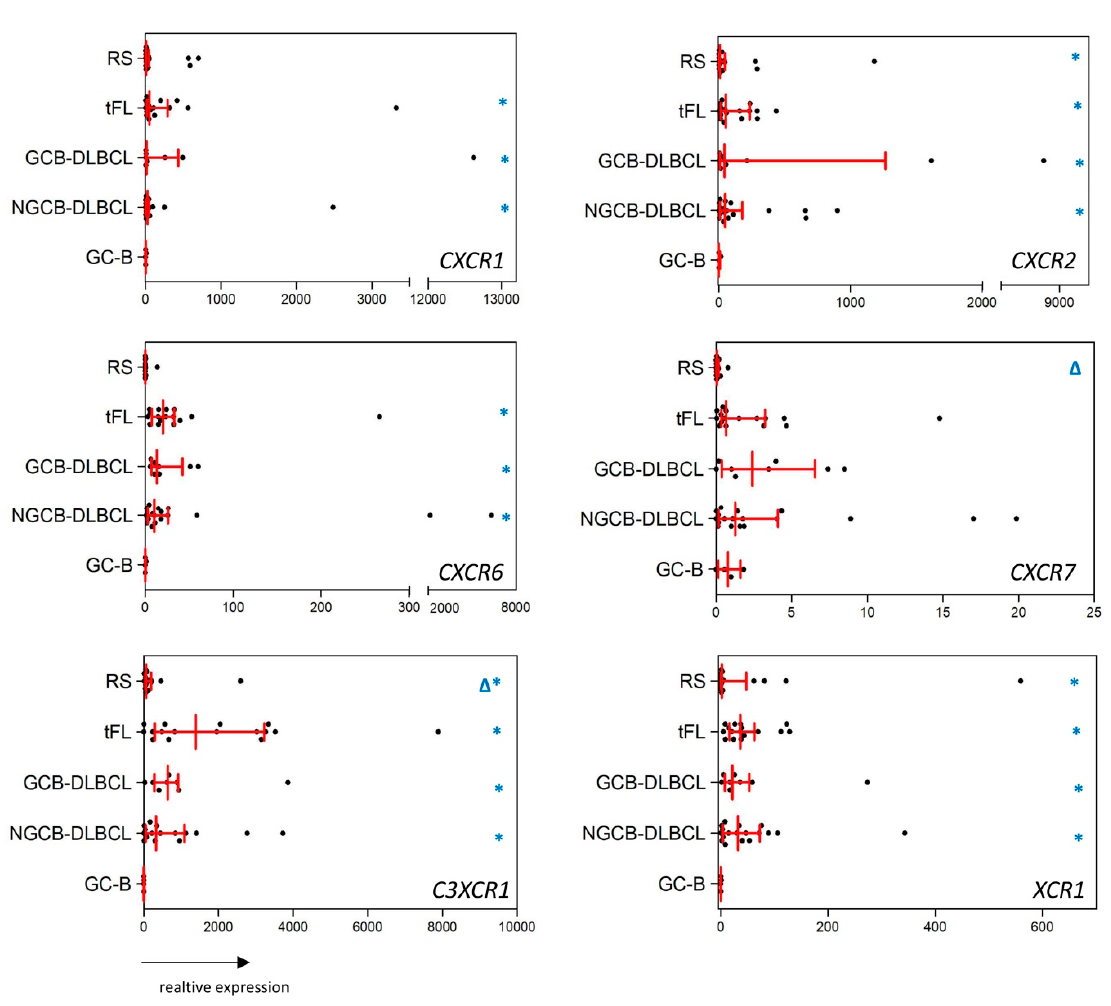
Figure 2. mRNA expression of CXCR, CX3CR1, and XCR1 chemokine receptors in RS, tFL, GCB-DLBCL, NGCB-DLBCL, and GC-B serving as healthy controls. Scatter plots show the mRNA expression of CXCR1 , CXCR2 , CXCR6 , CXCR7 , CX3CR1 , and XCR1 in RS, tFL, GCB-DLBCL, NGCB-DLBCL, and GC-B. GC-B denotes germinal center B-cells, which were isolated from non-neoplastic tonsils. Values of gene expression are calculated as relative expression. Red lines indicate median and interquartile range. * depicted in blue indicates significantly dysregulated chemokine receptors of a given lymphoma subgroup compared with GC-B ( p < 0.05). ∆ depicted in blue indicates significantly dysregulated chemokine receptors of RS compared with the tFL, GCB- and NGCB-DLBCL ( p < 0.05).